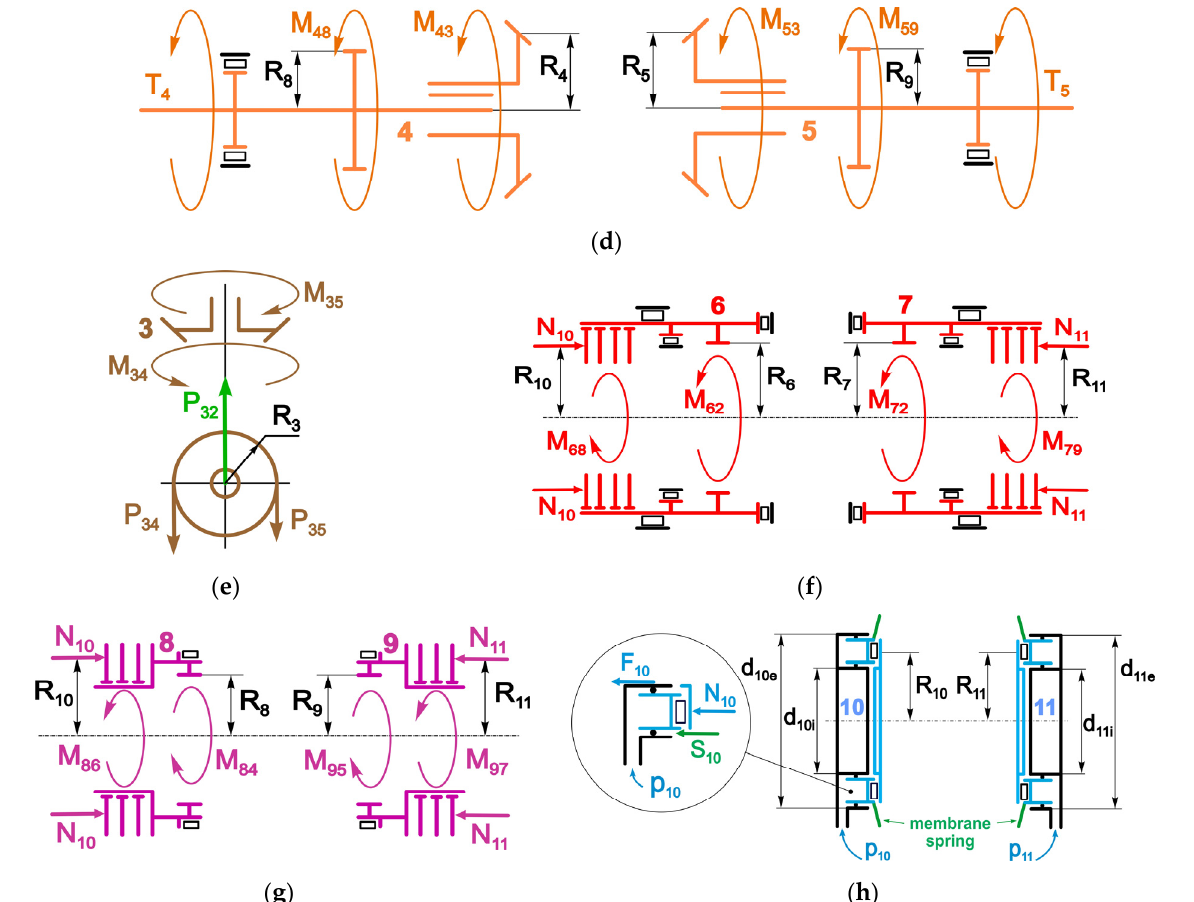
Figure 5. Parameters and force factors acting on the parts of the sport differential: ( a ) final drive’s hypoid gearing, ( b ) final drive pinion, ( c ) carrier body, ( d ) satellite, ( e ) side gears and output shafts, ( f ) clutches’ leading half-couplings, ( g ) clutches’ driven half-couplings, and ( h ) clutches’ hydraulic cylinders.